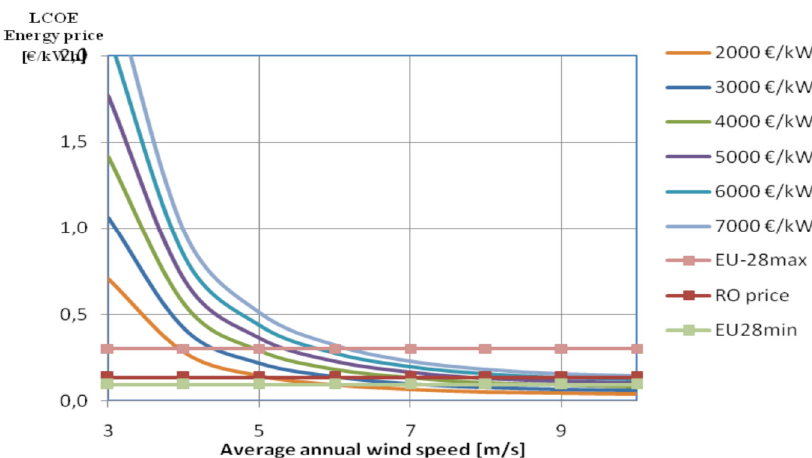
Fig. 3. LCOE for on-grid wind turbines and EU28 household energy